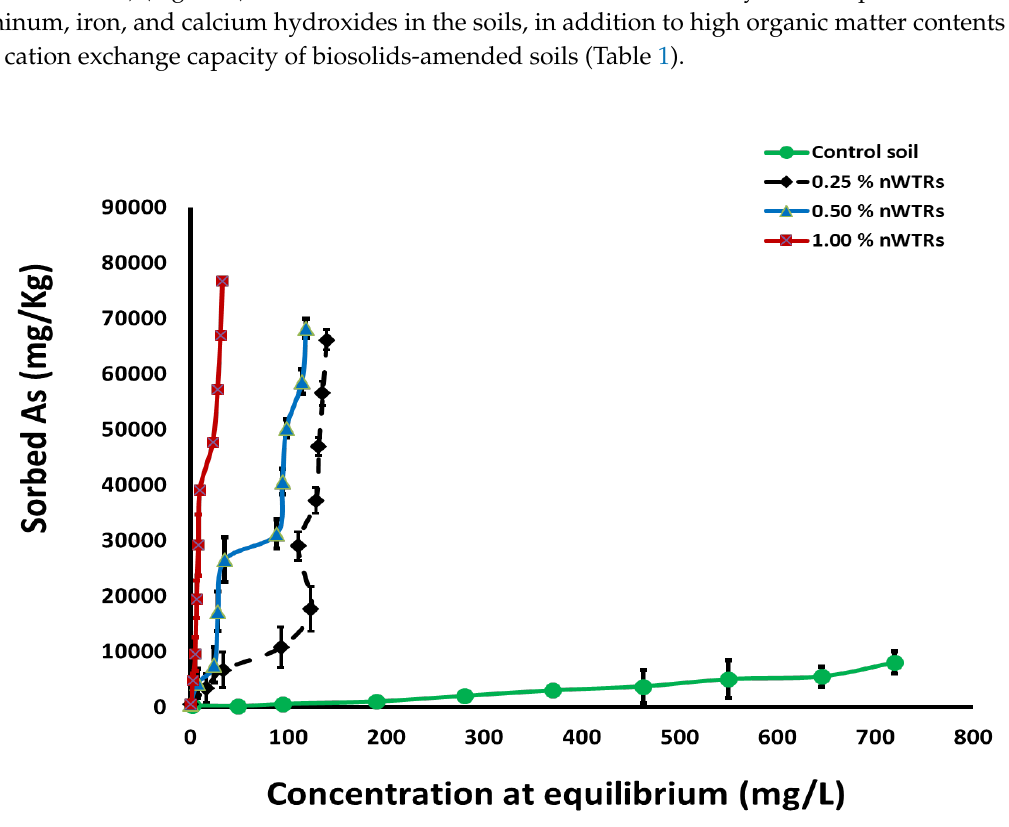
Figure 1. The amount of sorbed arsenic (As) in the calcareous soil amended with biosolids (3%, w/w) and with different levels of nWTRs of 0%, 0.25%, 0.5%, and 1% (w/w) at different equilibrium concentrations of As. Data shown are means and standard deviation (n = 3).The error bars were too small to be visible in the figure.